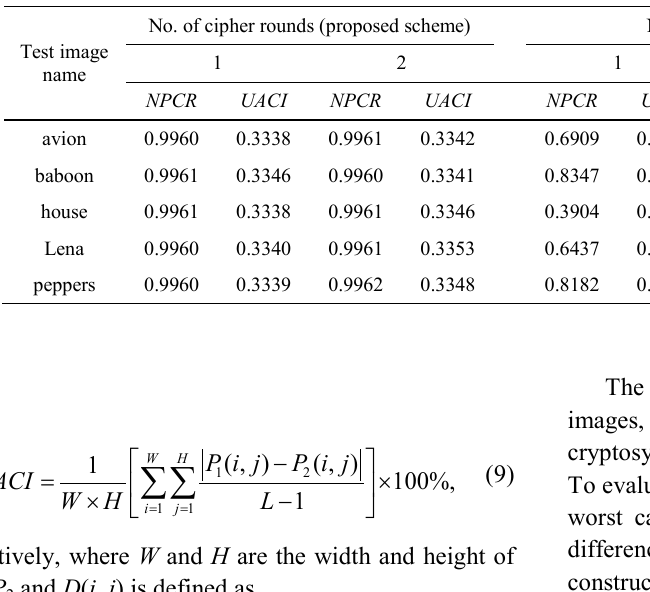
Fig. 2. The application of the proposed permutation algorithm. (a) the original peppers test image; (b) the image with 1-bit difference from (a); (c) the shuffled image corresponding to (a); (d) the shuffled image corresponding to (b); (e) the differential image between (c) and (d). Table 2. Results of NPCR and UACI